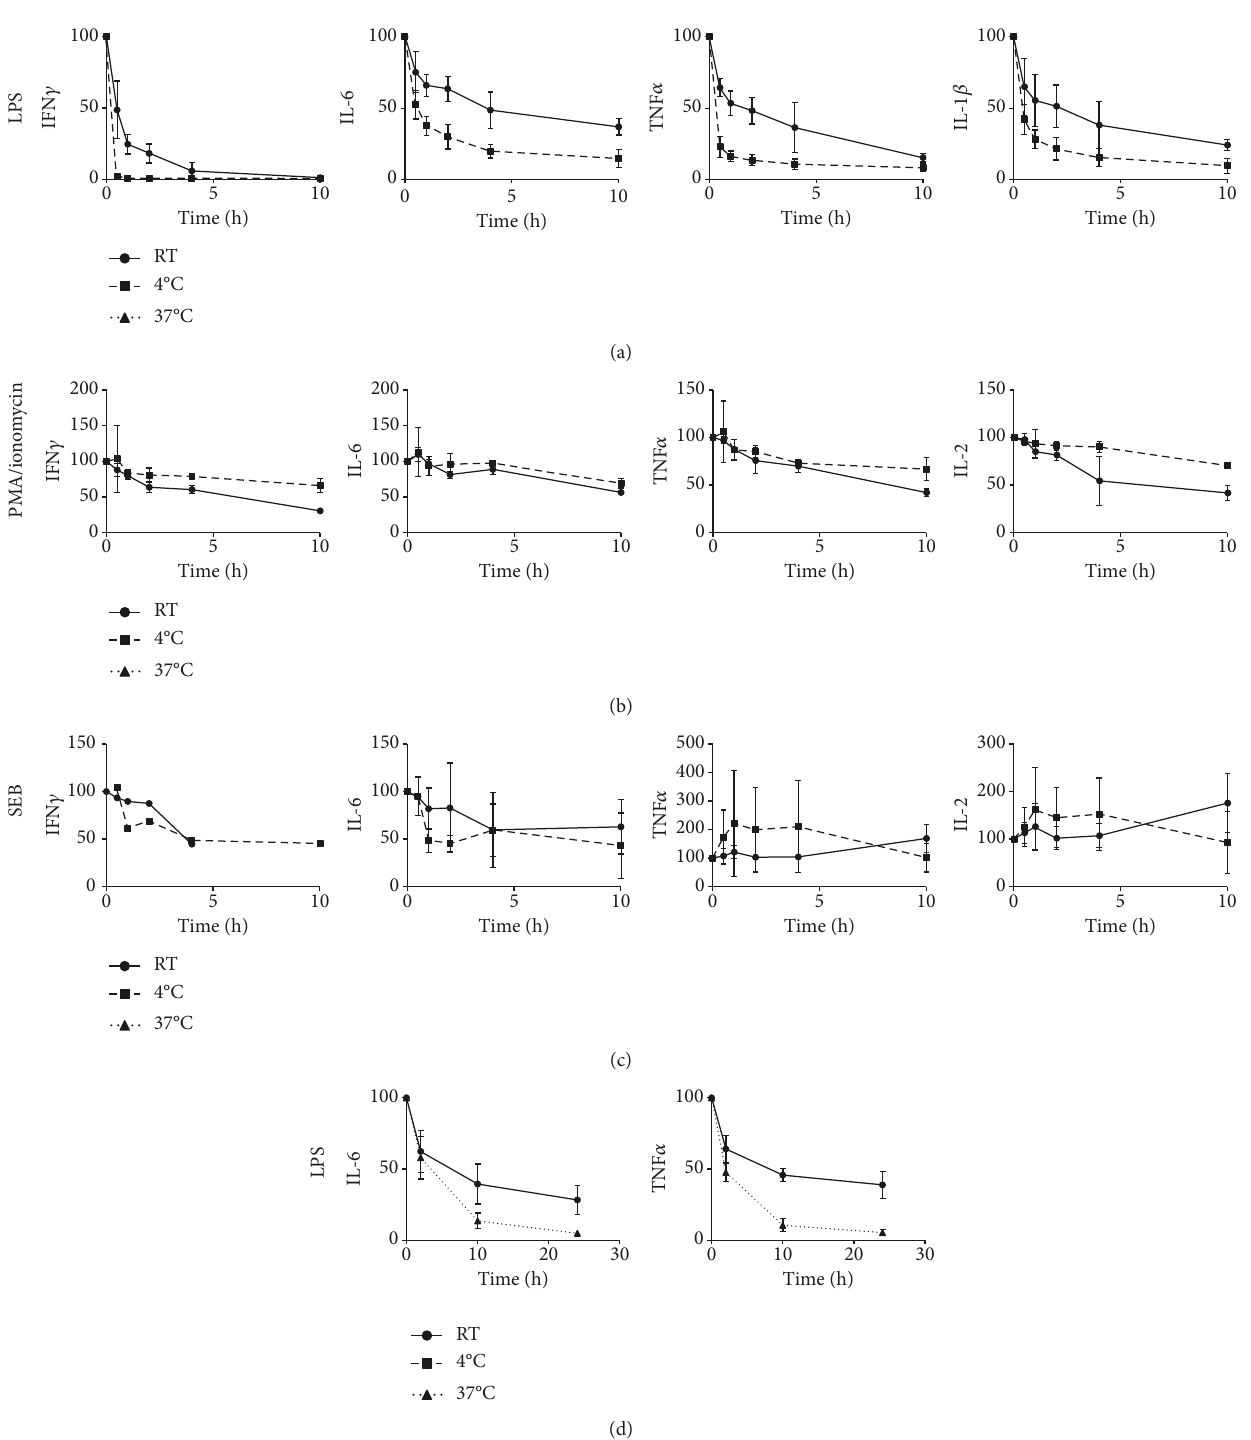
Figure 1: Cytokine release in whole blood culture supernatants (as % of the response at t = 0 , average plus SD). The whole blood of 3 donors was stimulated for 24 hours with LPS (a), PMA/ionomycin (b), or SEB (c). The whole blood of 5 donors was stimulated for 24 hours with LPS (d). The x -axis indicates the sample age (time span between blood collection and start incubation). The blood was stored at room temperature (continuous line), 4 ° C (dashed line (a – c)), or 37 ° C (dashed line